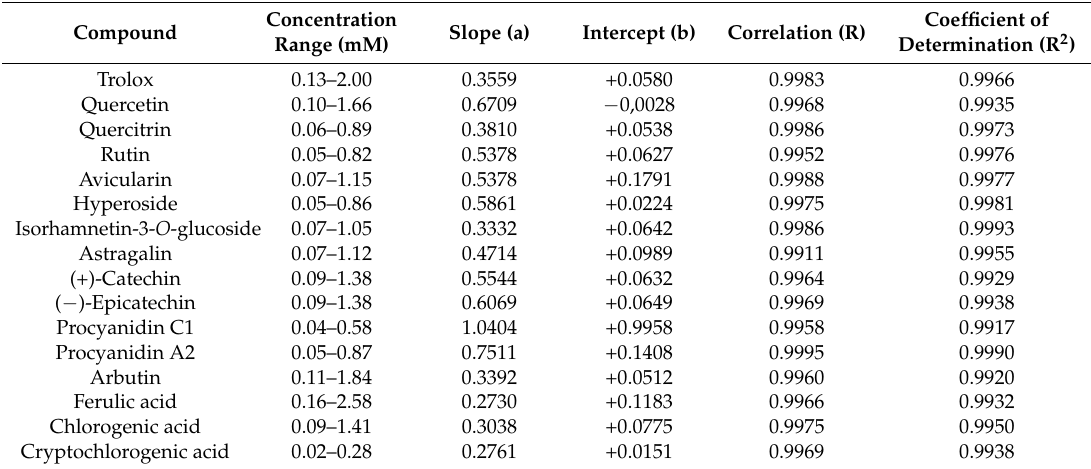
Table 3. Calibration curves (y = ax + b) data obtained by ABTS assay for tested compounds.